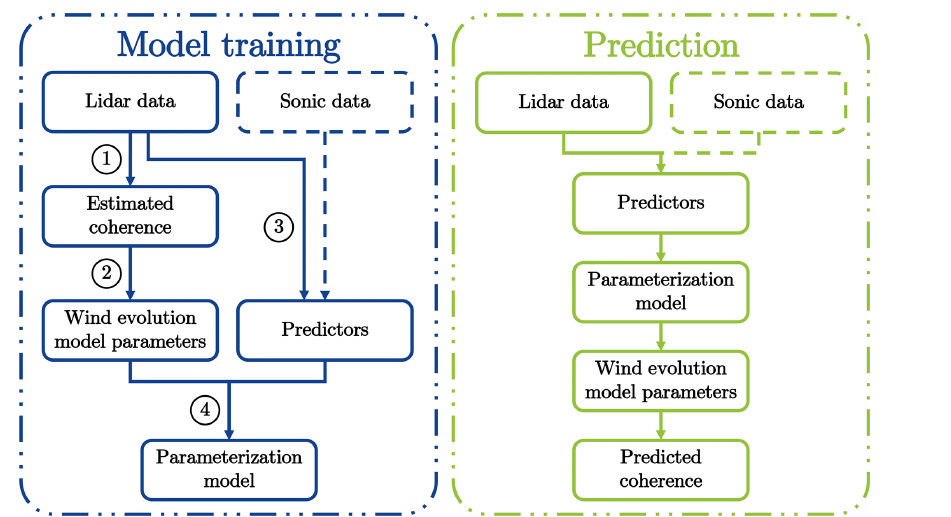
Figure 1. Concept and workflow of wind evolution prediction. The workflow of model training is the following. (1) Estimation of coherence using lidar data. (2) Determination of wind evolution model parameters by fitting the estimated coherence to a wind evolution model. (3) Calculation of potential predictors from measured data (mainly lidar data; sonic data could be involved if available). (4) Training of parameterization models using a machine learning algorithm.